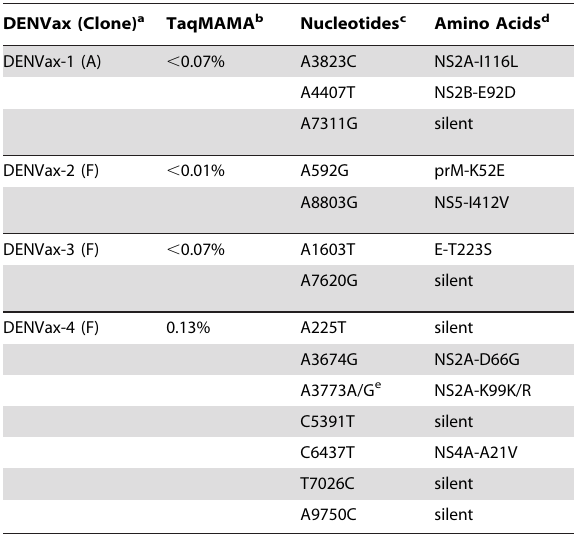
Table 3. Nucleotide and amino acid substitutions in MVS.